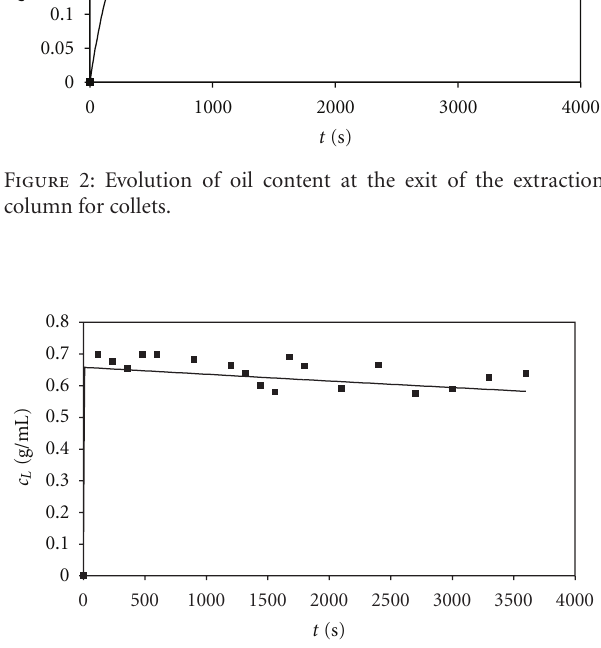
Figure 3: Evolution of oil content at the exit of the extraction column for hydrolyzed flakes.